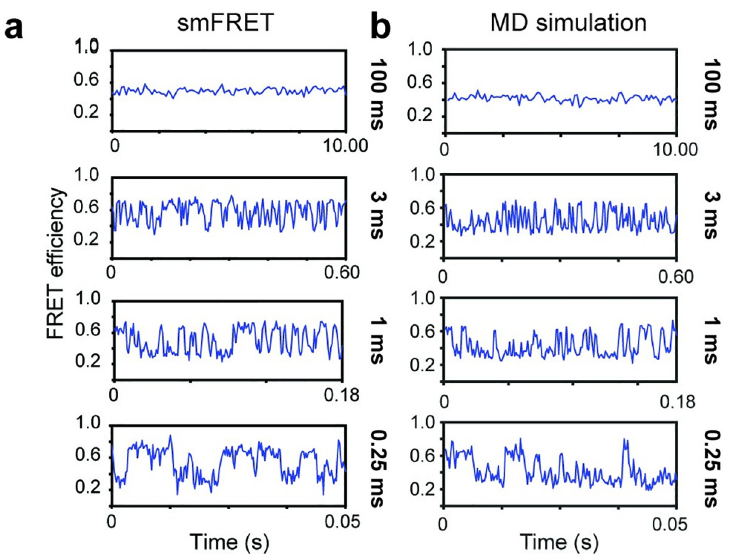
Fig 2. Recapitulation of experimental smFRET data from 200 simulations at 500 million-timesteps (total of 100 billion-time steps). (a) Representative experimental smFRET traces of the LIV-BP SS system at 0.25, 1, 3, and 100 ms exposure times [70]. (b) Representative FRET trajectories from MD simulations (including dye-linker interactions, see below) at the same exposure times as smFRET experiments. Effective exposure times for the MD simulations were controlled by averaging together the FRET efficiency values of consecutive time steps; for example, each data point in the 100 ms exposure is an average of 4x10 9 time steps. For all MD simulations and smFRET experiments, fluorophores were conjugated to position 67 and 181 of LIV-BP SS